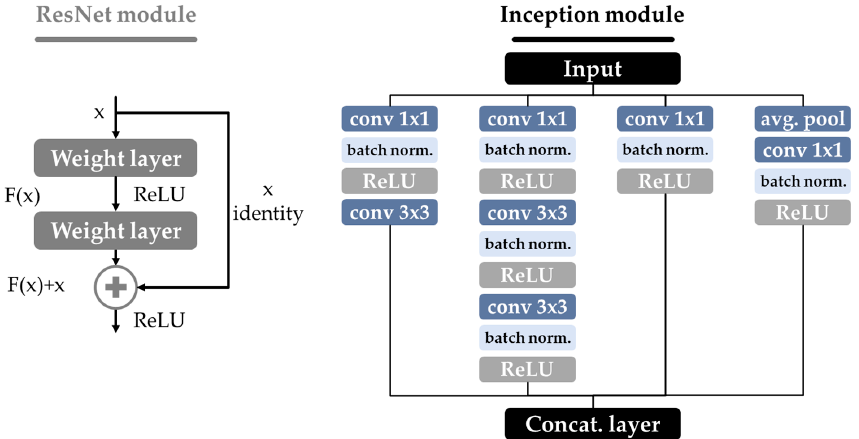
Figure 4. Example of a residual building block and the Inception module according to [36,37].